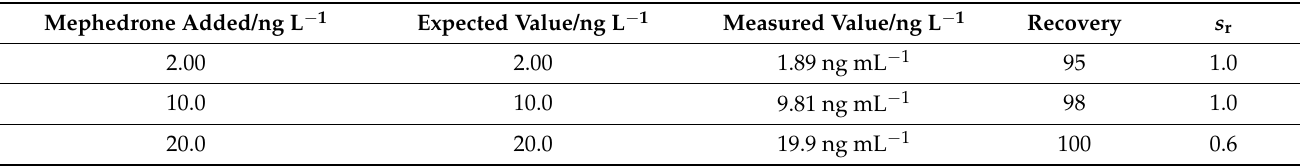
Table 2. Recovery studies of mephedrone in urine samples.